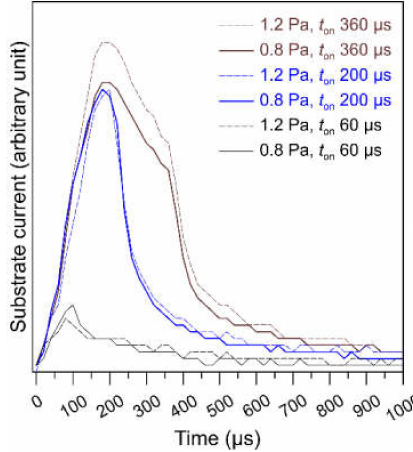
Figure 4. The responded substrate bias current pulse shapes at a constant substrate bias pulse voltage of − 1000 V for 1 ms which are synchronized with Cr target discharges of di ff erent HiPIMS pulse widths at di ff erent argon